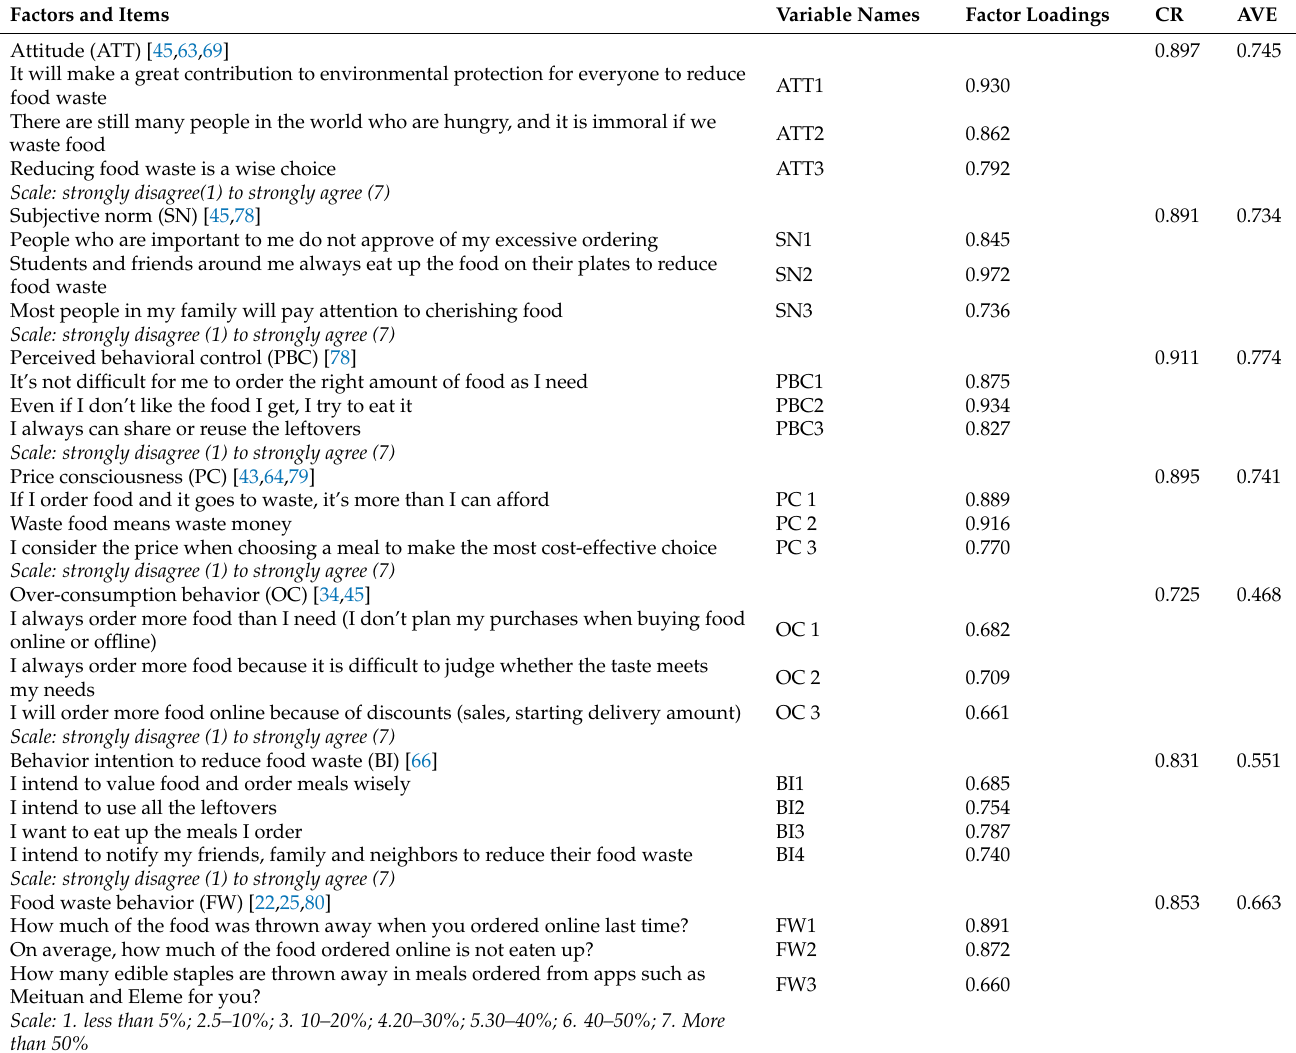
Table 2. Results of Confirmatory Factor Analysis (N =